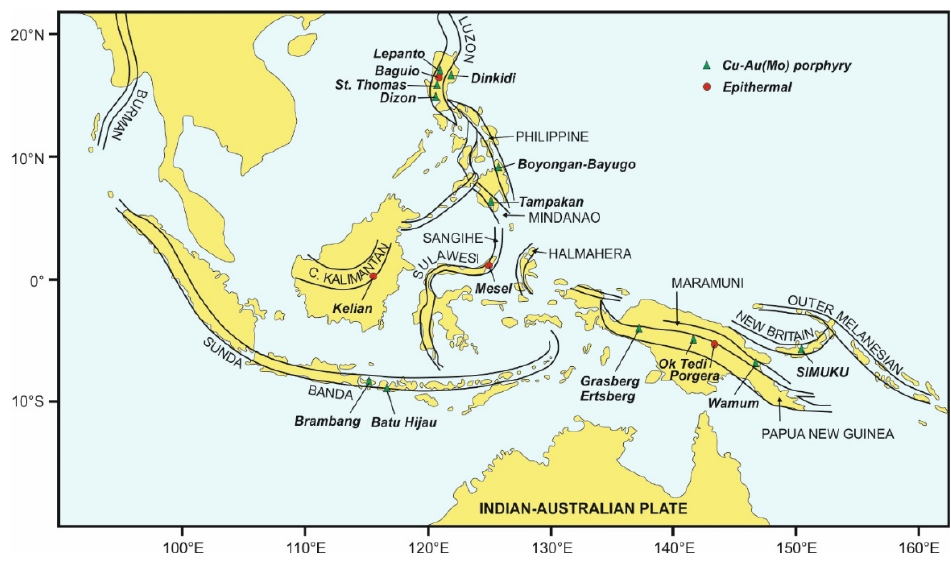
Figure 12. General tectonic setting and distribution of Cu–Au(Mo) porphyry and Au–Ag epithermal deposits associated with adakites and high-Nb basalts (modified after